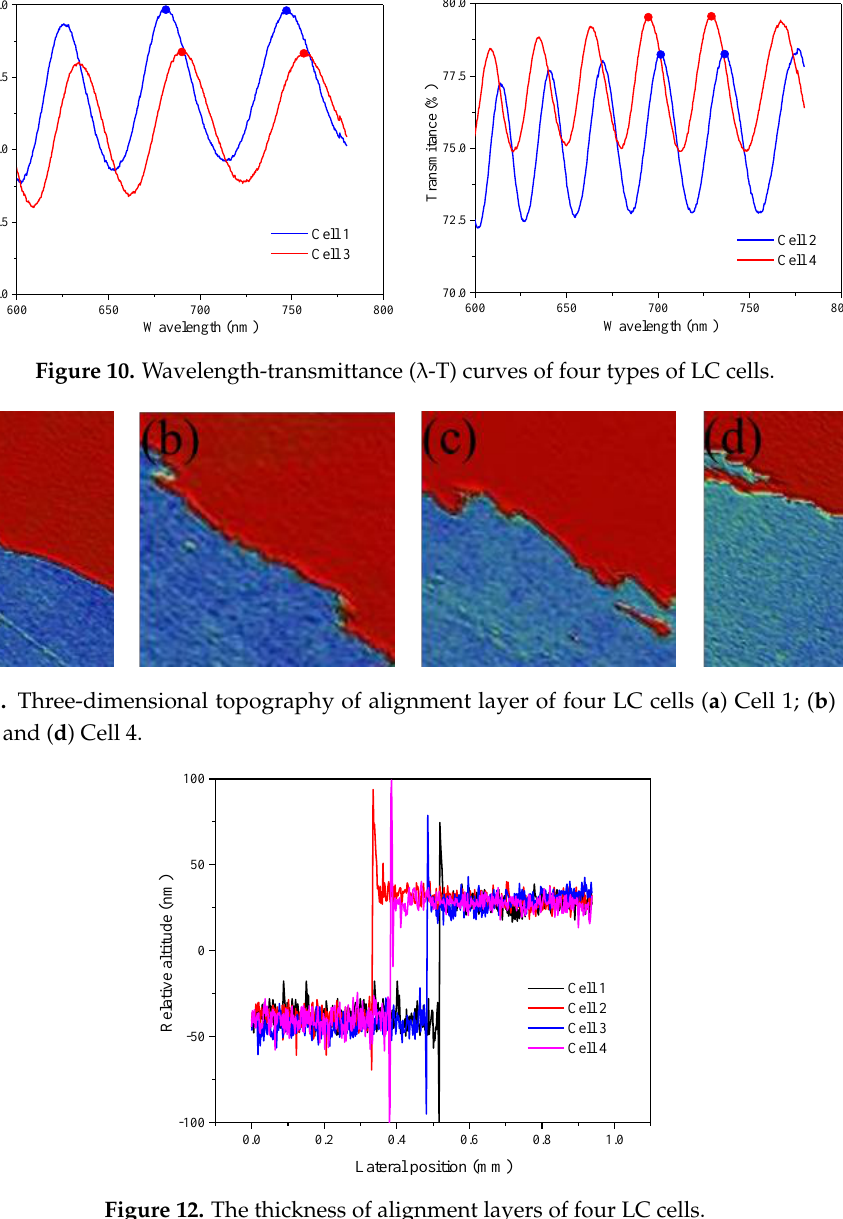
Figure 12. The thickness of alignment layers of four LC cells.